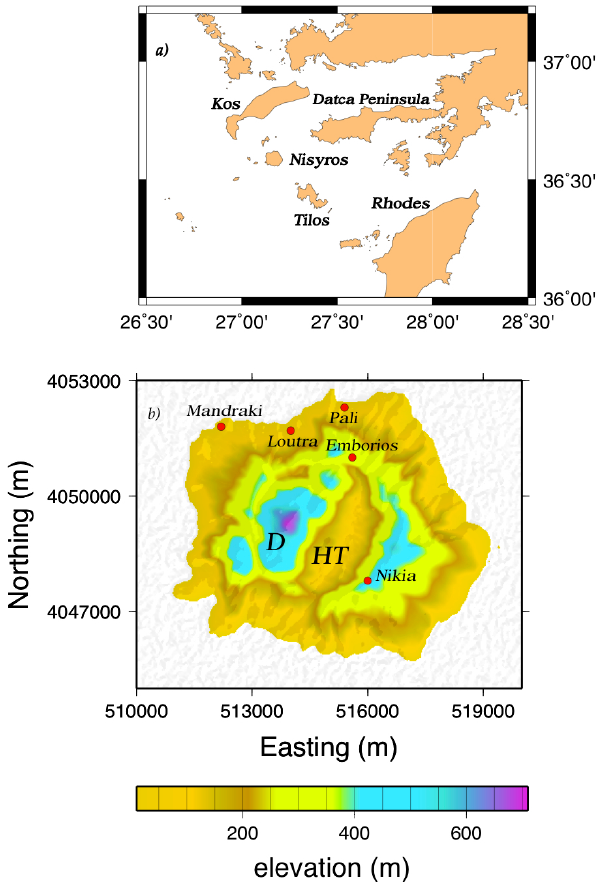
Fig. 1. (a) Map of the Dodecanese region of the Aegean indicating location of Nisyros. For a regional context see Fig. 5. (b) Color- coded digital elevation model of Nisyros from SRTM 90m data in- dicating location of main population centres of the island, the hy- drothermally active caldera floor (HT) and the post-caldera domes (D).